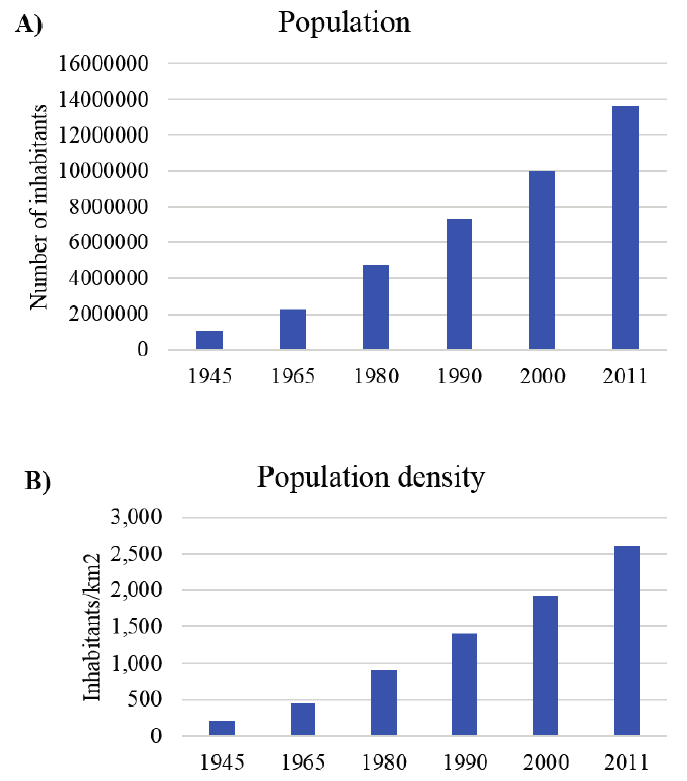
Figure 2. ( A ) Growth of population and ( B ) of population density of Istanbul. Data analyzed from 1945 to 2011